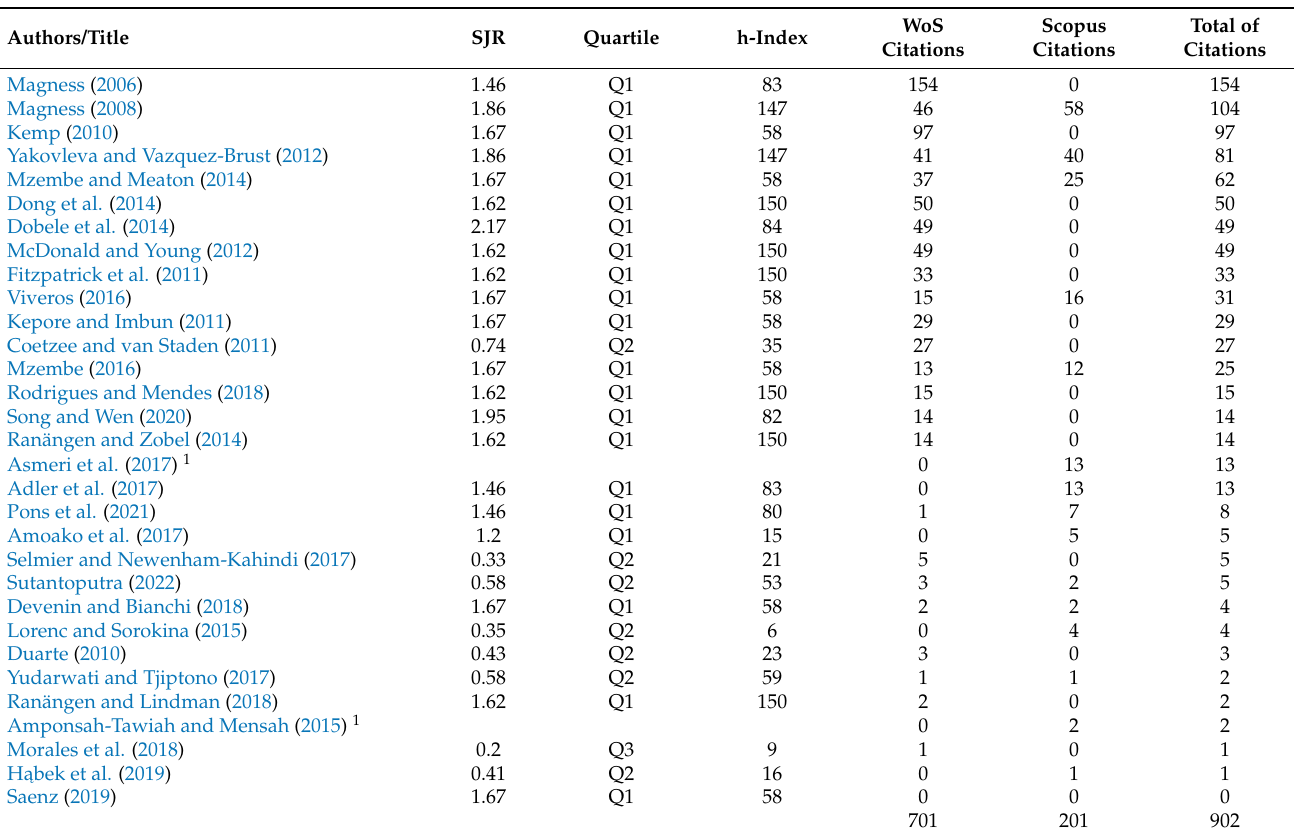
Table 2. Citations per article (n = 31).